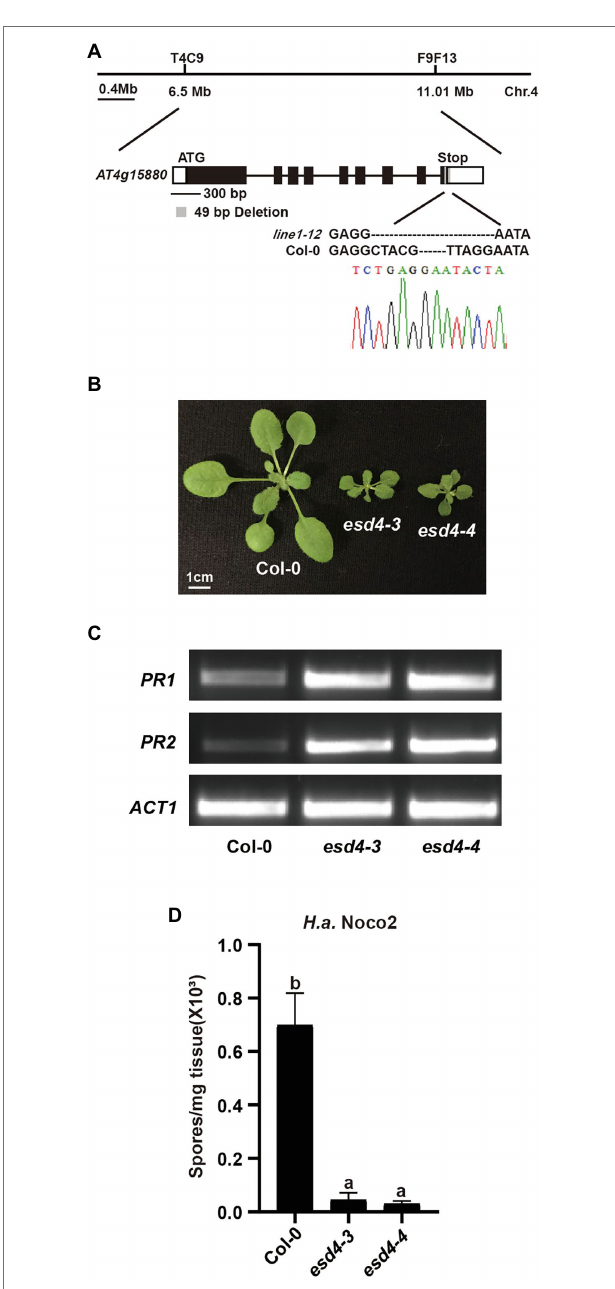
FIGURE 2 | Loss function of ESD4 is responsible for autoimmunity in line1- 12 . (A) Mapping-based cloning of line1-12 . Line1-12 was mapped to a region between marker T4C9 and F9F13 on chromosome 4. Gene structure of ESD4 ( AT4G15880 ) with esd4-3 deletion is highlighted in gray. Black boxes and lines indicate exons and introns, respectively. White boxes represent UTRs. Chromatogram of Sanger sequencing confirmed the deletion in esd4- 3 . (B) Morphologies of 3-week-old soil-grown plants of the indicated genotypes under long-day conditions. (C) Expression of PR1 and PR2 in the indicated genotypes. ACTIN1 serves as internal control. Experiments were repeated three times with similar results. (D) Growth of H.a. Noco2 on the indicated genotypes. The values indicate averages of replicates ± SD ( n = 3). Different letters indicate statistical differences among different samples ( p < 0.05, one-way ANOVA, n = 3). Experiments were repeated twice with similar